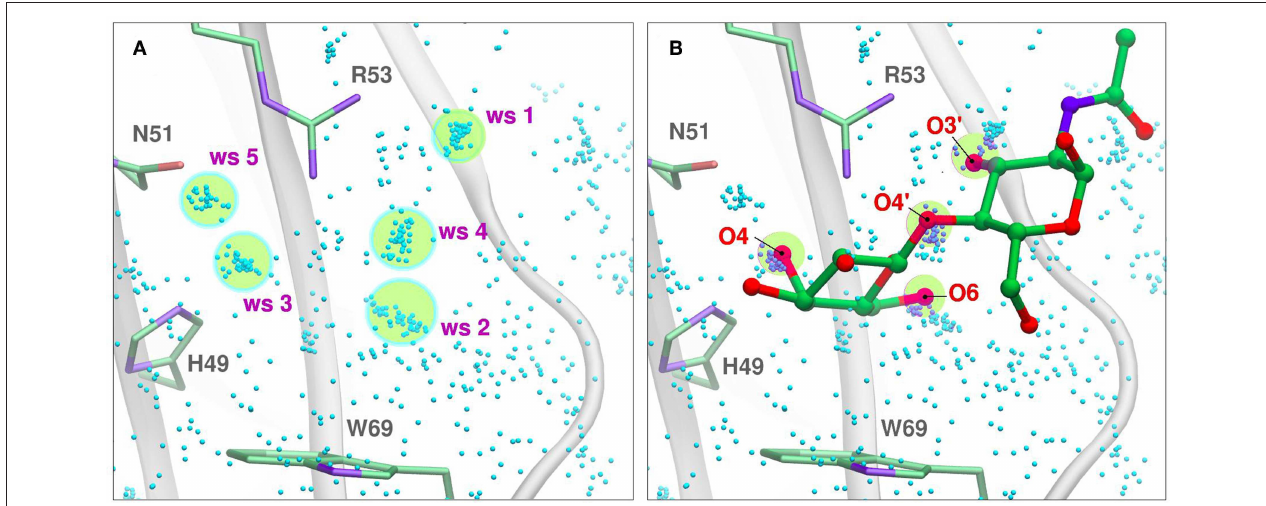
FIGURE 5 | Solvent structure determination by Molecular Dynamics of Gal-7 CBS (PDB id: 1bkz). Water molecules from many snapshots along the simulation trajectory are superimposed and shown as small cyan dots (Hydrogens atoms omitted for clarity). (A) Water Sites 1–5 are depicted as transparent yellow circles. (B) N-acetyl-lactosamine coordinates of “PDB id: 5gal” superimposed into the previous image, highlighting all the oxygen atoms that displace a Water